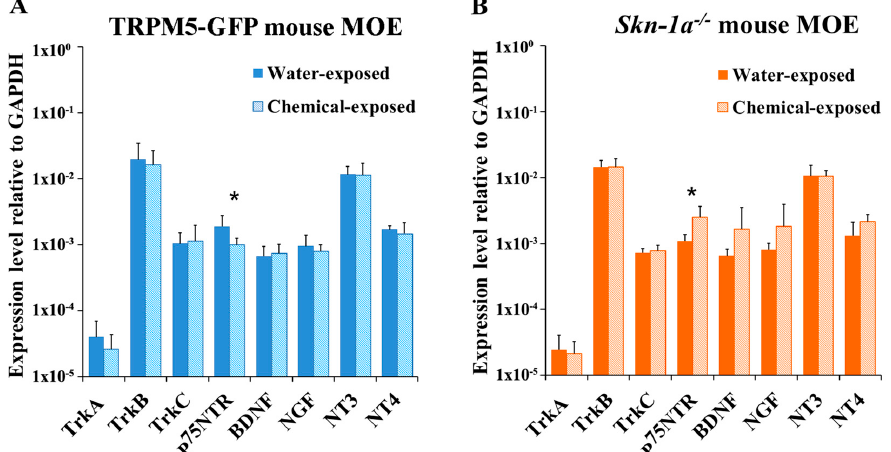
Figure 3. Chemical exposure induced differential alterations in NT and NTR expression in the